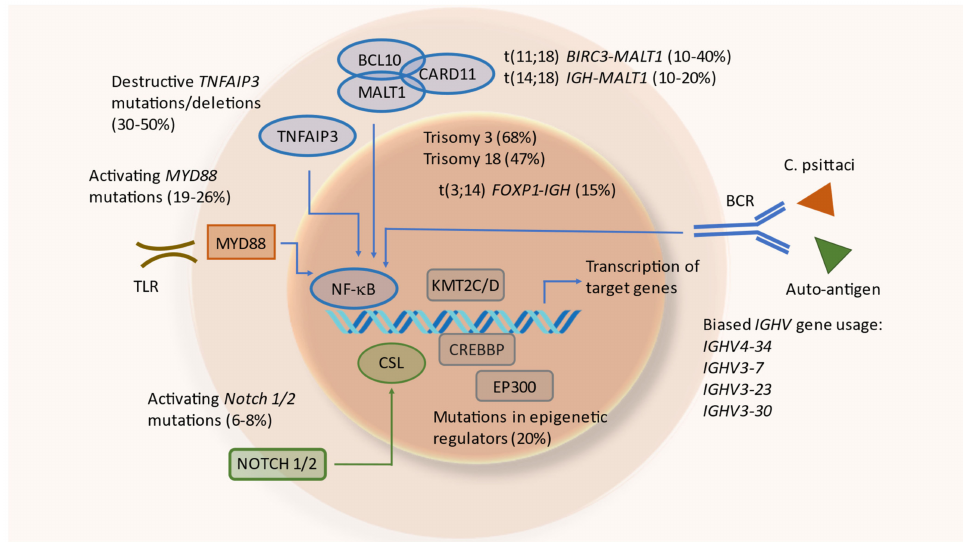
Figure 3. Mechanisms and pathways involved in the pathogenesis of OAMZL. TLR: toll-like receptor; C. psittaci : Chlamydophila